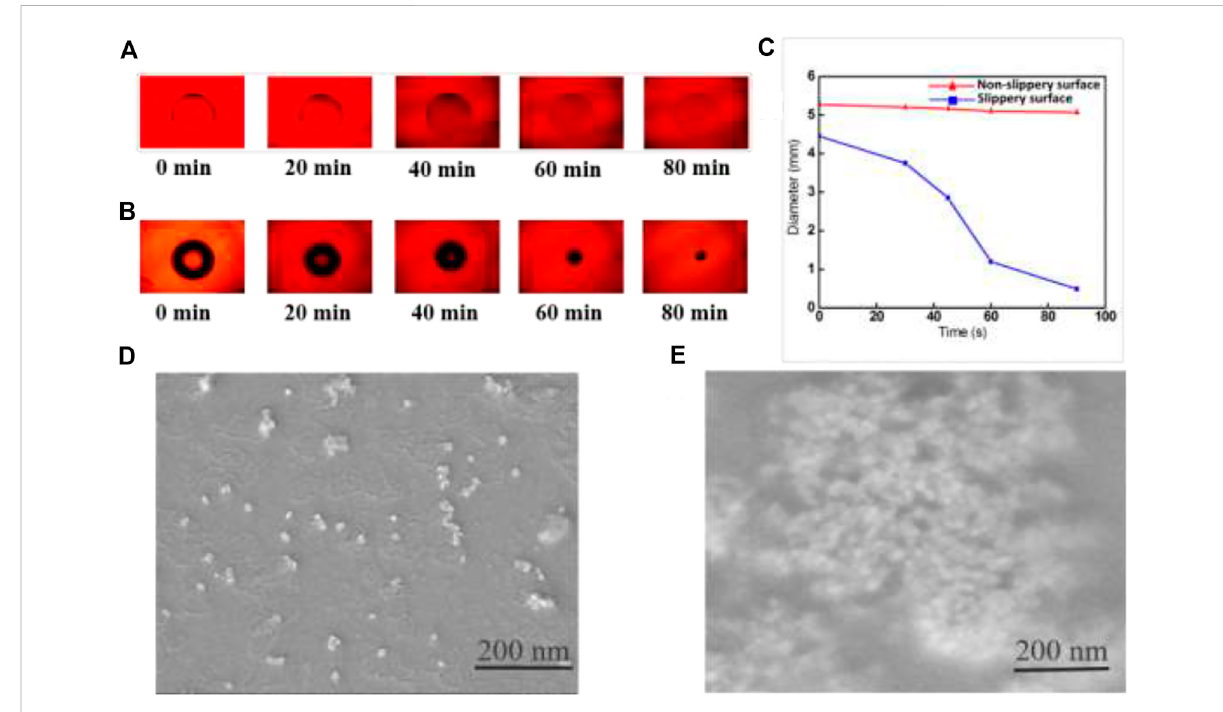
FIGURE 3 (A) Optical microscopy images of droplets evaporating at different times on a hydrophilic (B) hydrophobic surface. (C) The contact diameter (CD)ofadropletonnon-slipperysurfacesandslipperysurfacesasafunctionofevaporationtime.SEMimagesofGNRssolutionafterevaporation (D) on the hydrophilic surface and (E) lubricated liquid-infused hydrophobic